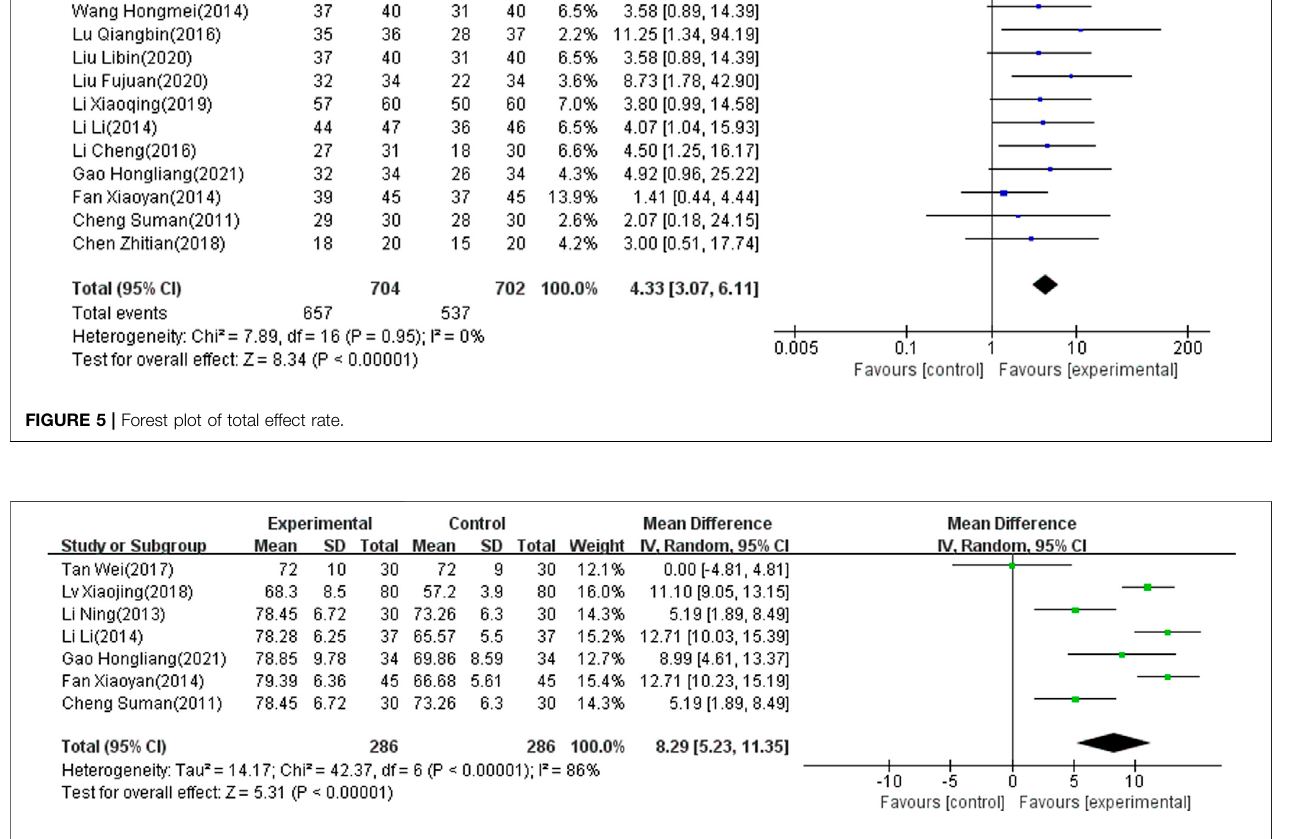
FIGURE 6 | Forest plot of MBI